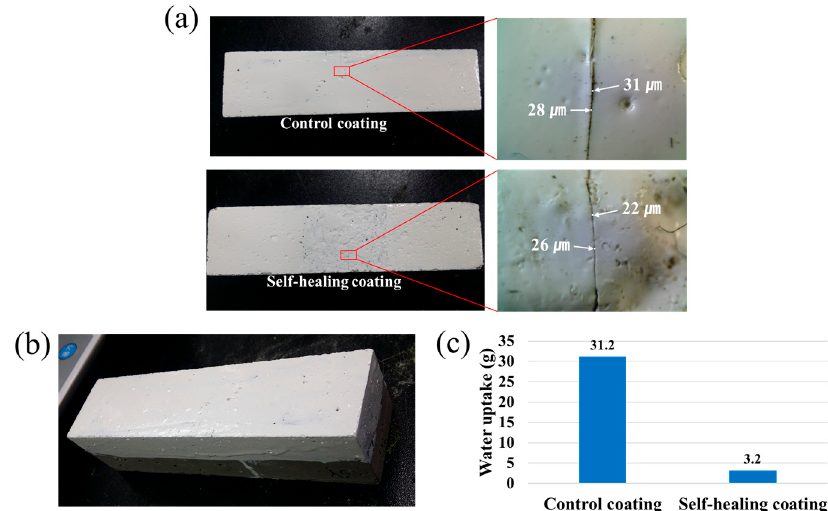
Figure 6. Water permeability test for coated mortar specimens. ( a ) Photographs of scratched coatings ( left ) and enlarged scratch areas ( right ); scratch widths are indicated; ( b ) A photograph of coated mortar specimen; ( c ) Amount of water uptake upon immersion of the scratched surface in water for 48 h.